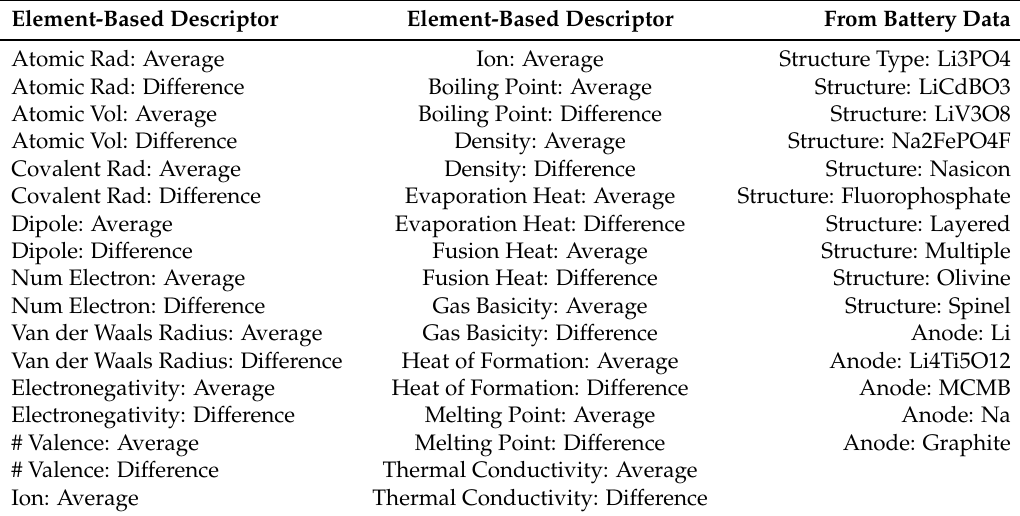
Table A1. The original 49 descriptors that were considered for learning. All averages are assumed to be weighted.